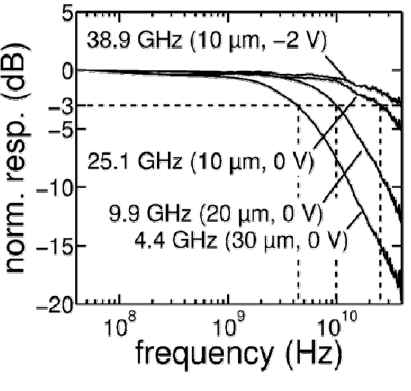
Figure 7. Normalized frequency response at a wavelength of 1,552 nm for PIN detectors with diameters varying from 10 to 30 μ m. From [14].